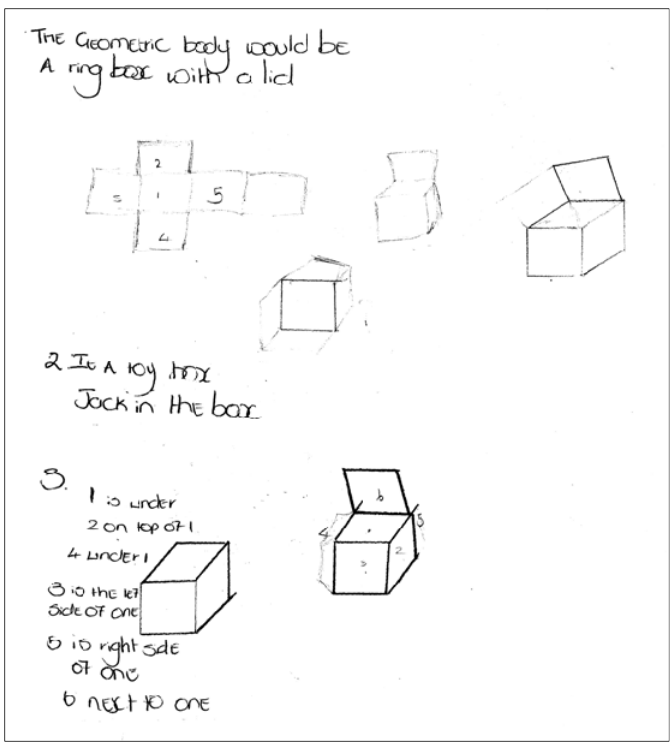
Figure 1 : Learner B’s written response to Task 1